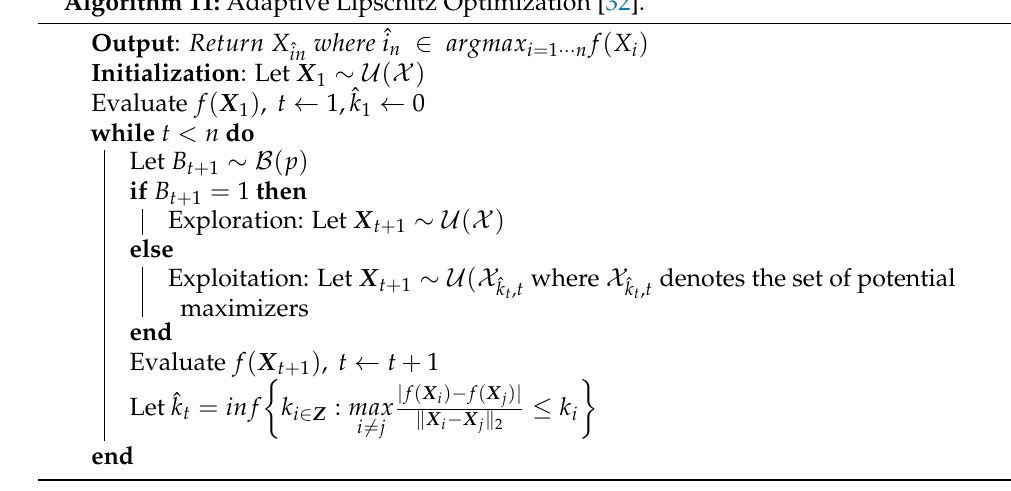
Algorithm 11: Adaptive Lipschitz Optimization